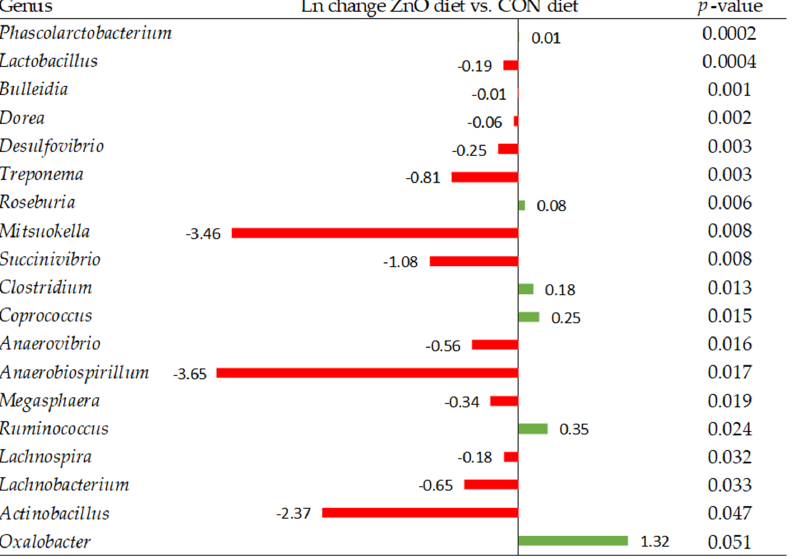
Figure 6. Differentially abundant taxa (Ln change) between diets supplemented with antimicrobial compounds (ZnO) and control diet (CON). Positive values (green color) and negative values (red color) indicate greater and lower abundance, respectively. Taxa are sorted by level of significance (from higher to lower). Only significant taxa are presented ( p- value < 0.10). Data are means of 6 replicate pens for the main effect of level (one pig per replicate pen was sampled).